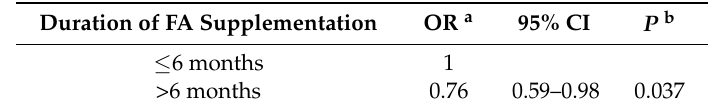
Table 3. The association between the duration of FA supplementation during pregnancy and risk of